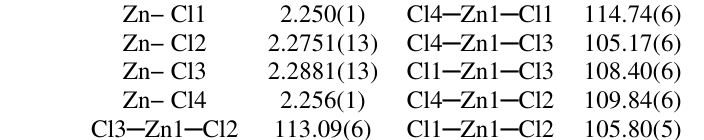
) -C H NH ] ZnCl .2H O. 3 2 6 3 3 2 4 2